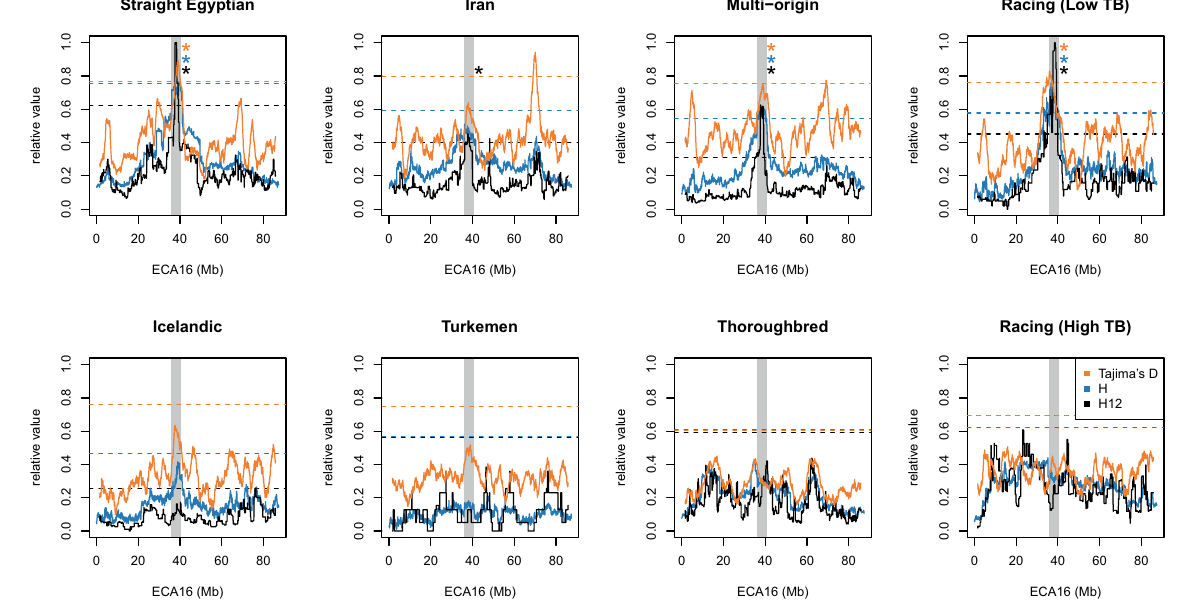
Figure 6. Selection scan statistics highlight a candidate region on ECA 16 containing GPX1 , a gene important for protection from exercise-induced oxidative damage across Arabian lineages. H, H 12 , and reflected Tajima’s D statistics were all scaled to 0 – 1. 99 th percentile threshold values are plotted as dashed horizontal lines for each statistic. The selection scan peak with the highest count of overlapping peaks (“multi-strain” group, H statistic, overlapping with 11 other peaks) is shown as the vertical gray region. Colored asterisks indicate which test statistics had peaks exceeding the indicated threshold within the region of